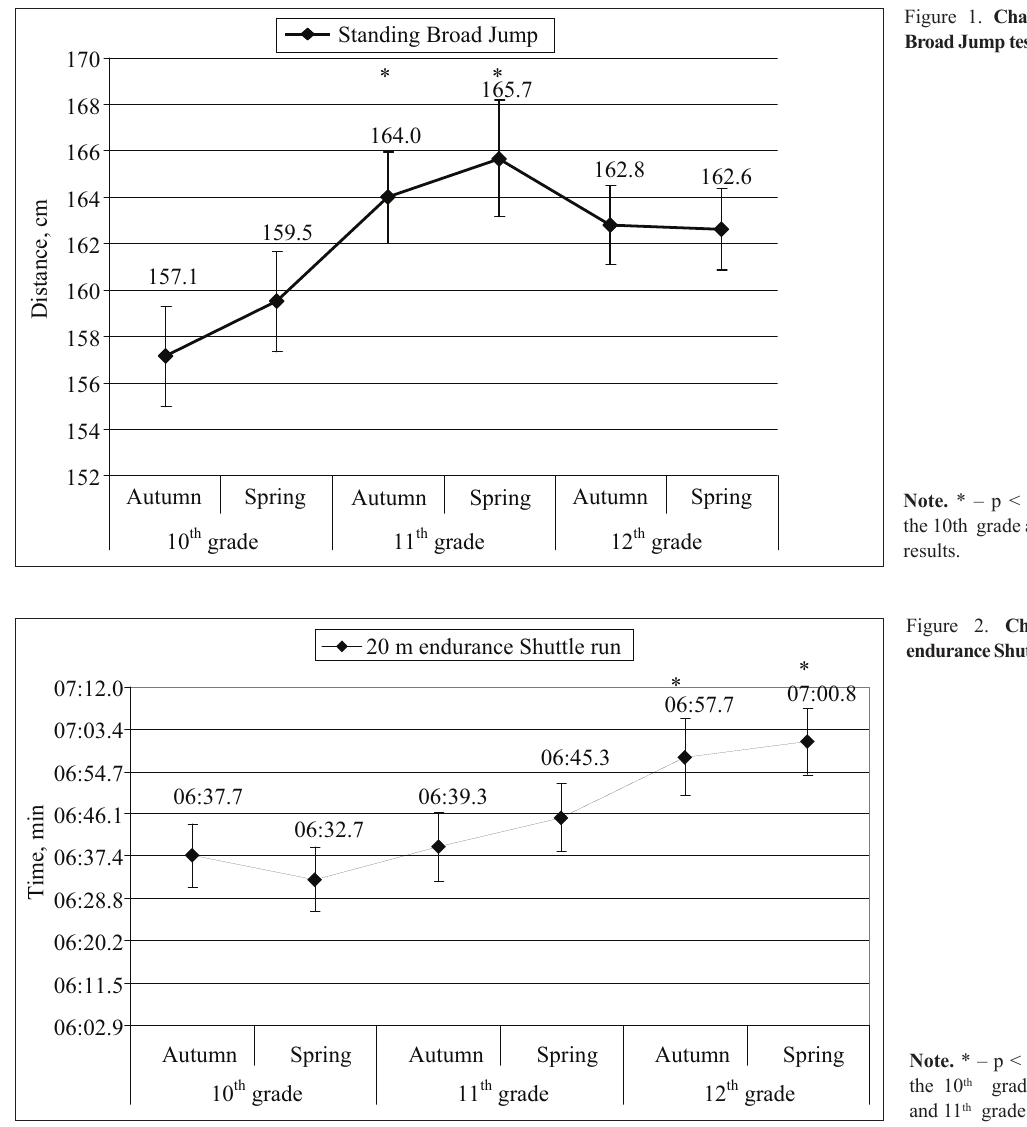
Figure 1. Changes in Standing Broad Jump test results